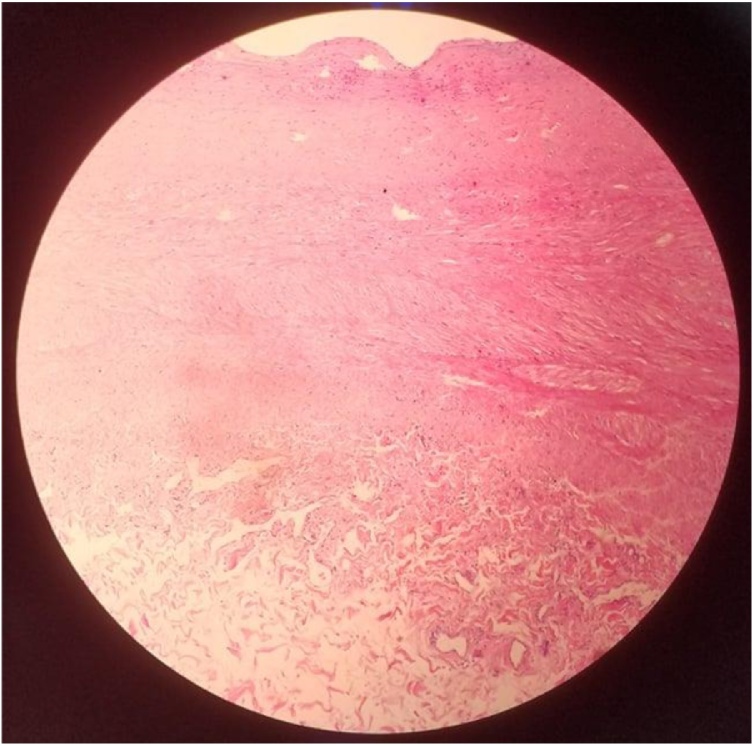
Histopathological examination showed the degeneration due to atherosclerosis.